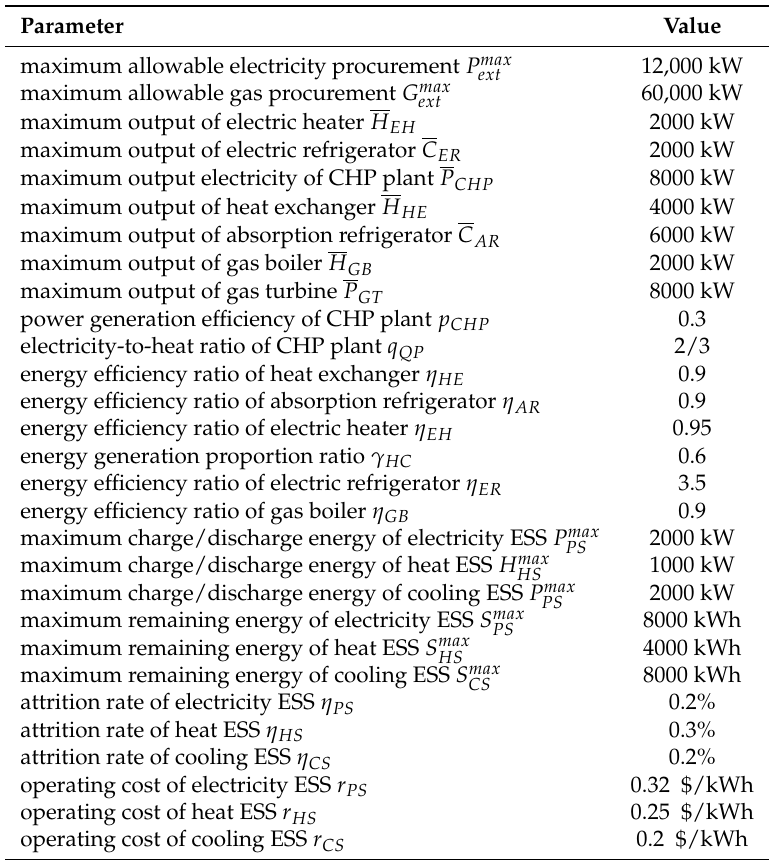
Table 1. Parameters and corresponding values of